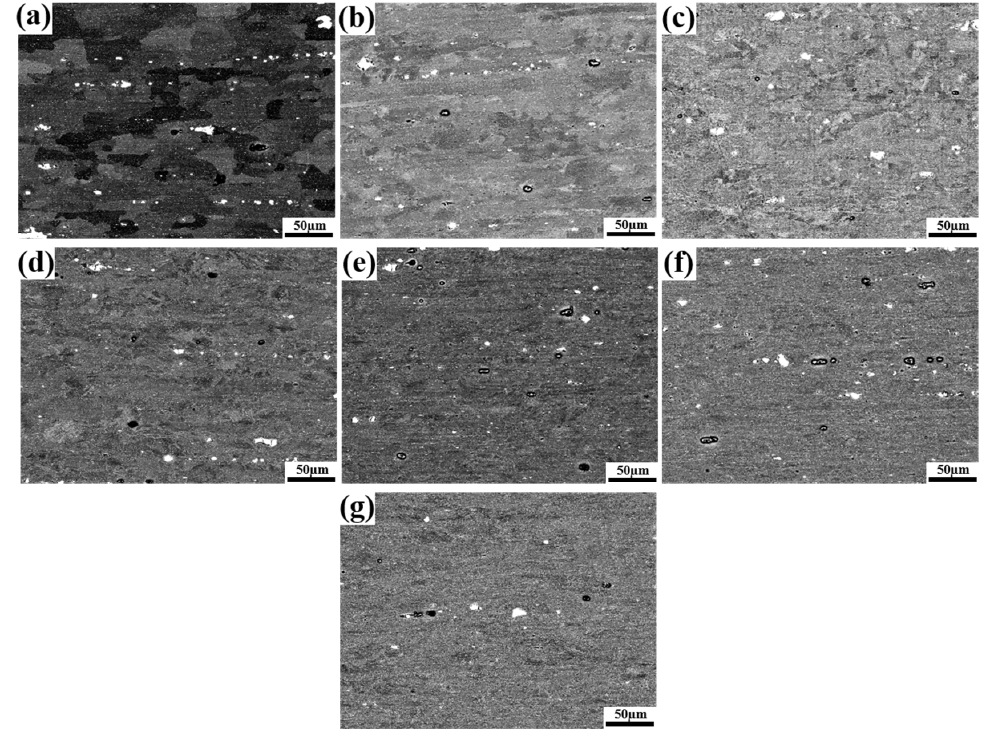
Figure 3. SEM maps of 5A06 aluminum alloy sheets under di ff erent CRF deformation amounts: ( a )